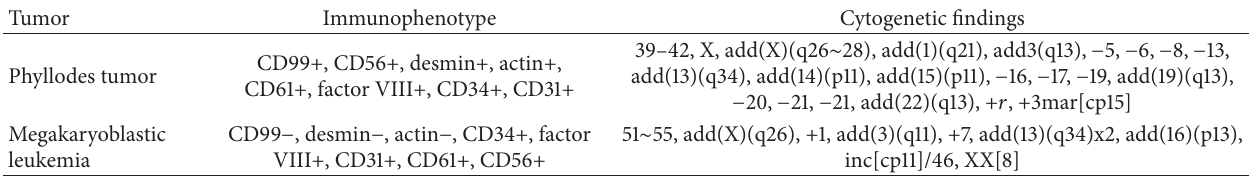
Table 1: Immunophenotypic and cytogenetic characteristics.